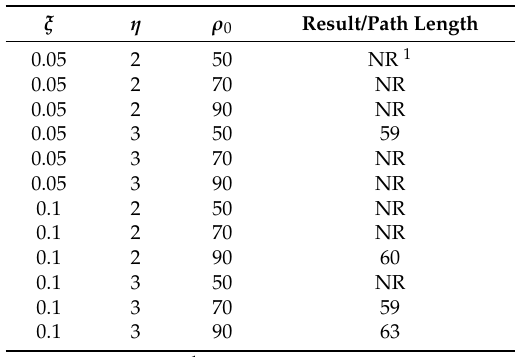
Table 4. Path length on map-2 for potential field method.